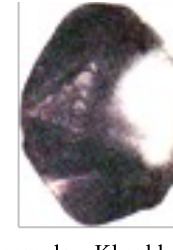
Fig. 1. Bodaibin type bacterial microfossils (Spheromorphides).Paleoproterozoic Khangiltsig metacomplex, Khankhukhei block in western Mongolia. Natural size of the microfossils is overstated 600 times (after Mitrofanov et al.,